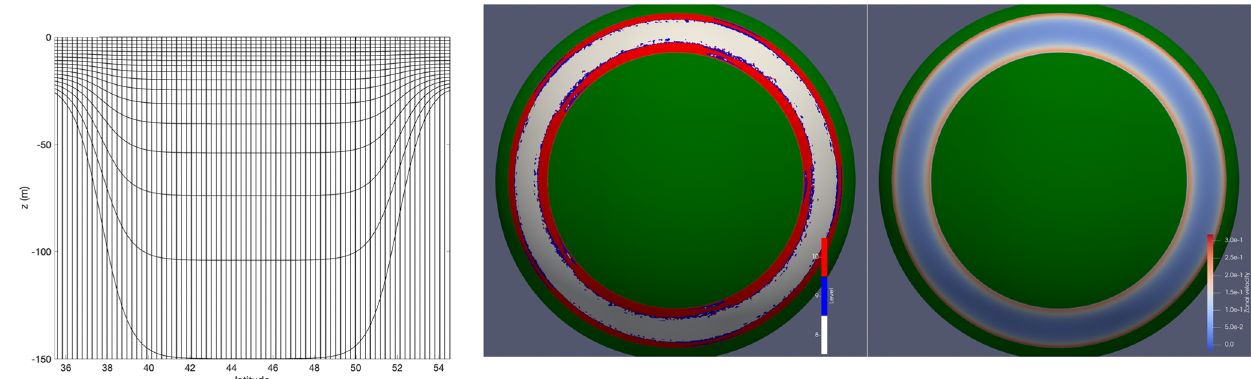
Figure 5. Upwelling test case. Left: vertical grid, with mean horizontal spacing at resolution J = 8. Right: horizontal adaptive grid and zonal velocity at day 2 at vertical level 8. The levels j = 8 , 9 , 10 correspond to mean resolutions (cid:49)x = 1 , 0 . 5 , 0 .